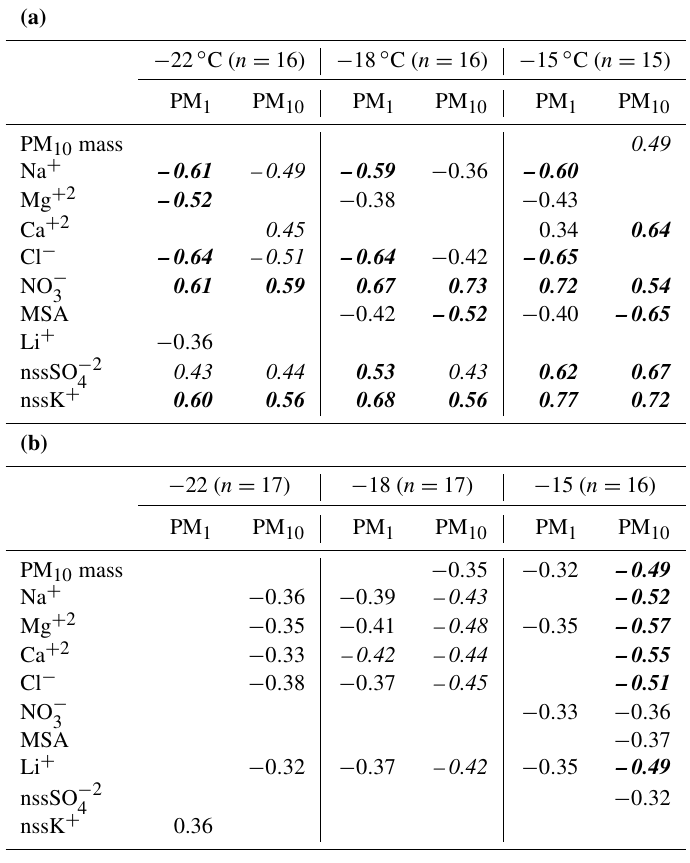
Table 3. (a) Correlations of n INP, in PM 1 and PM 10 samples by DFPC, with chemical tracers during the spring campaign. Coefficients reported in italics are statistically significant at p < 0 . 10, while those in bold are statistically significant at p < 0 . 05. Coefficients associated with p > 0 . 2 have not been reported. (b) Correlations of n INP, in PM 1 and PM 10 samples by DFPC, with chemical tracers during the summer campaign. Coefficients reported in italics are statistically significant at p < 0 . 10, while those in bold are statistically significant at p < 0 . 05. Coefficients associated with p > 0 . 2 have not been